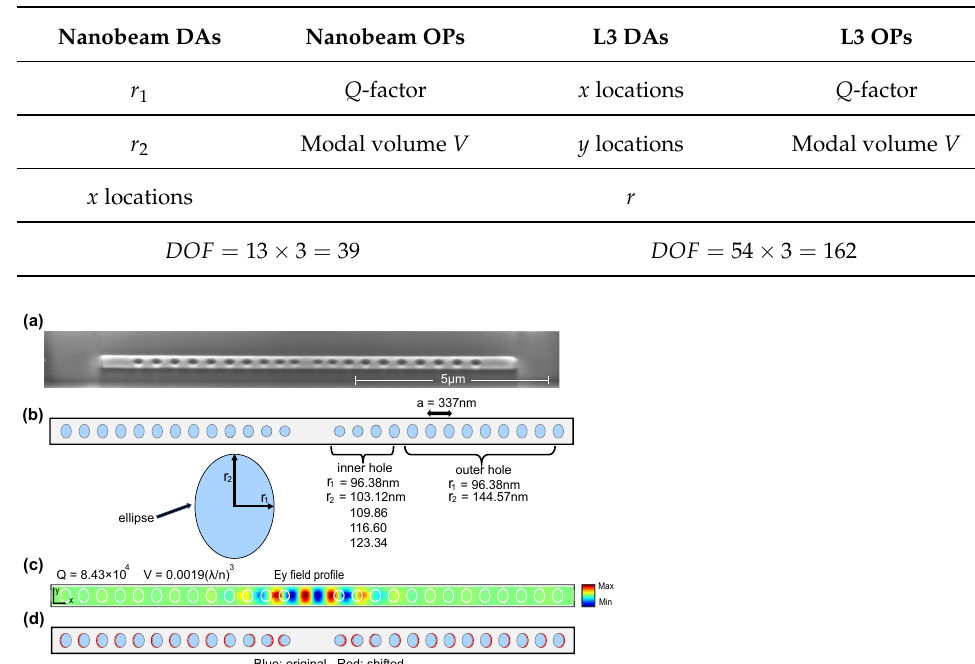
Table 2. Specifications of the dataset, generated according to Section 2.2, for training LRS-RCNN (DA = design parameter, OP = optical property, and DOF = degree of freedom). Left panel: nanobeam; right panel: L3 nanocavity. DAs such as “ x locations” and “ r ” refer to the x coordinate and radius of each individual air hole, respectively. Corresponding OPs are computed by FDTD simulation.